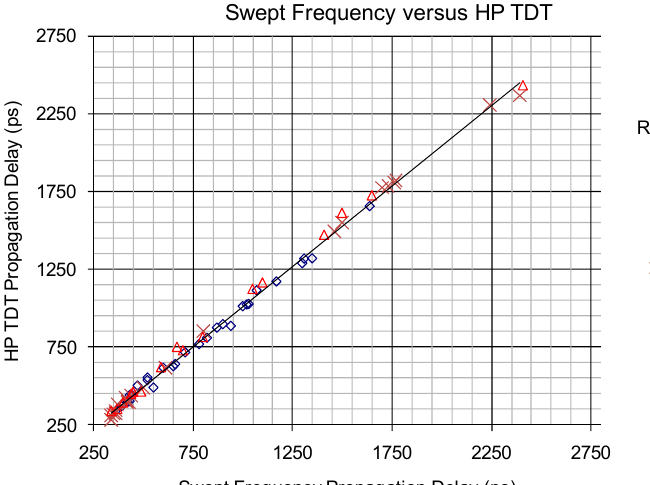
Figure 4. Propagation Delay (ps) comparison between a high-end TDT, 12GHz bandwidth, and the experimental Swept Frequency System for sand, Olton clay loam and Acuff loam.